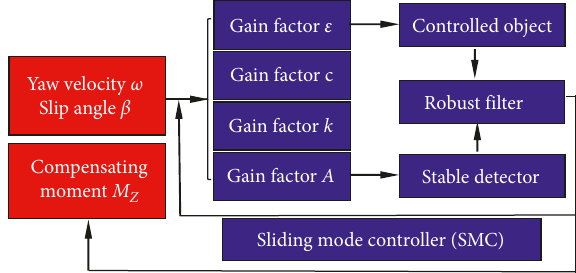
Figure 10: Sliding mode structure controller.